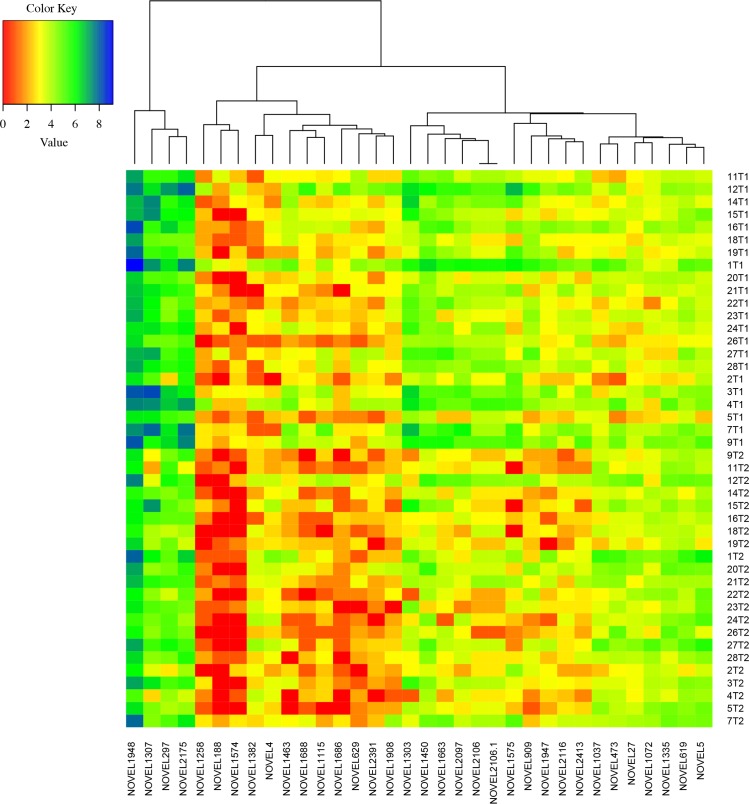
Differential novel transcript expression.Heatmap showing expression of differentially expressed novel transcripts in all individuals before (T1) and after (T2) training in Period 1. Read counts for each novel transcript per individual has been plotted as log2(read count), (n = 22 individuals).